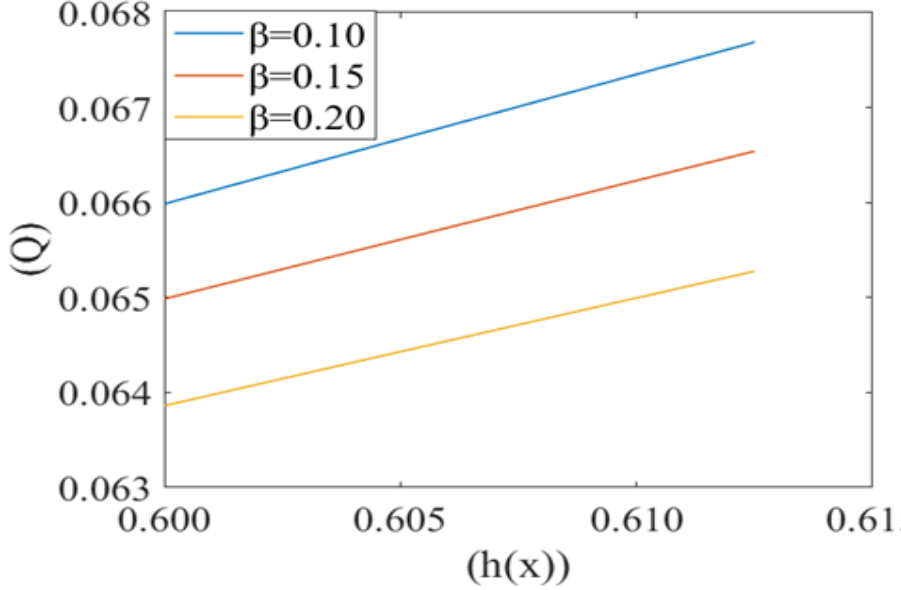
Figure 9. Variation of flux per unit length in the backward direction (leak back ( Q )) with the height of plasma film h(x) for different values of cell compliance ( β ) with Re = 0.25, P1 = 7, P2 = 5, k =